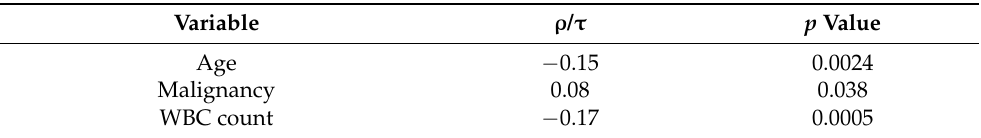
Table 6. Spearman or Kendall (for categorical, binary or ordinal variables) correlations between select characteristics and days from CDI diagnosis to